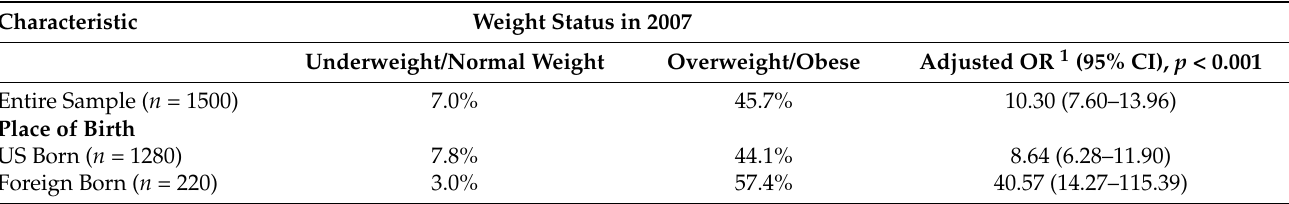
Table 4. Weight status in 2007 and probability of becoming overweight/obese in